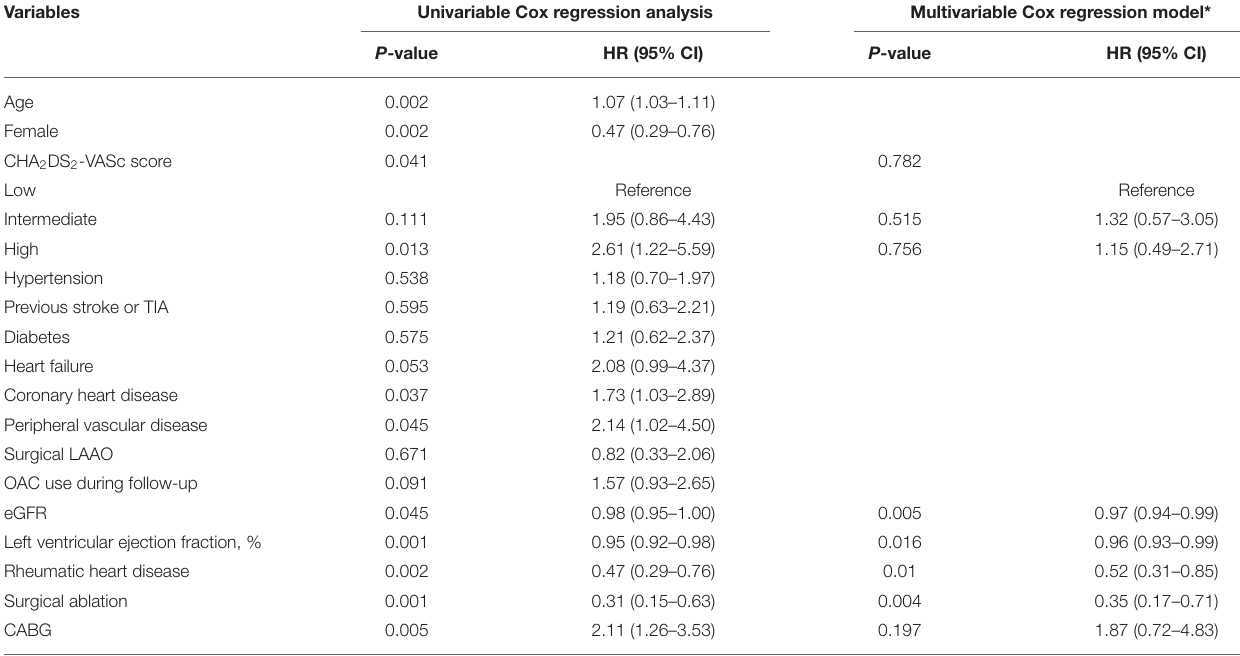
TABLE 3 | The factors associated with all-cause death in patients with atrial fibrillation and bioprosthetic valve ( n = 903).